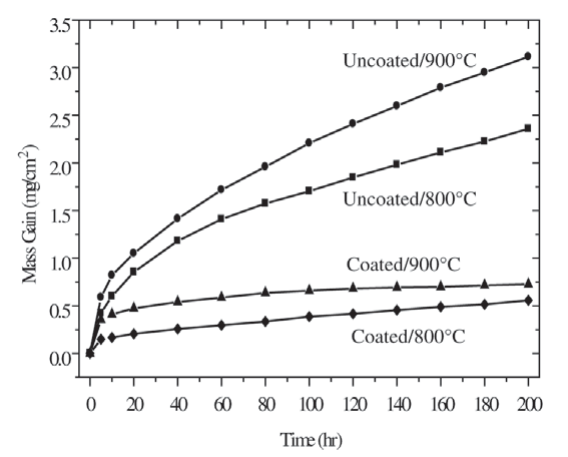
Al-Nb with ESD 3